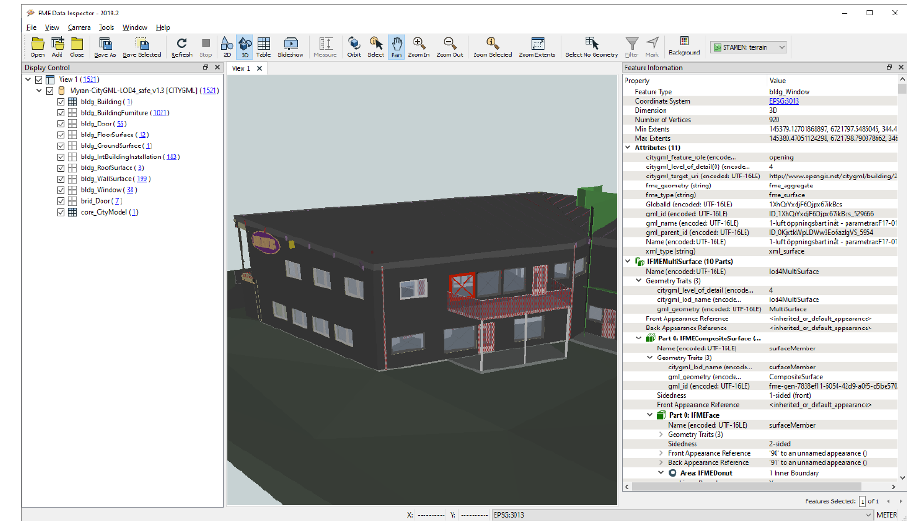
Figure 5. Views of the Myran model converted to CityGML by means of FME 2019